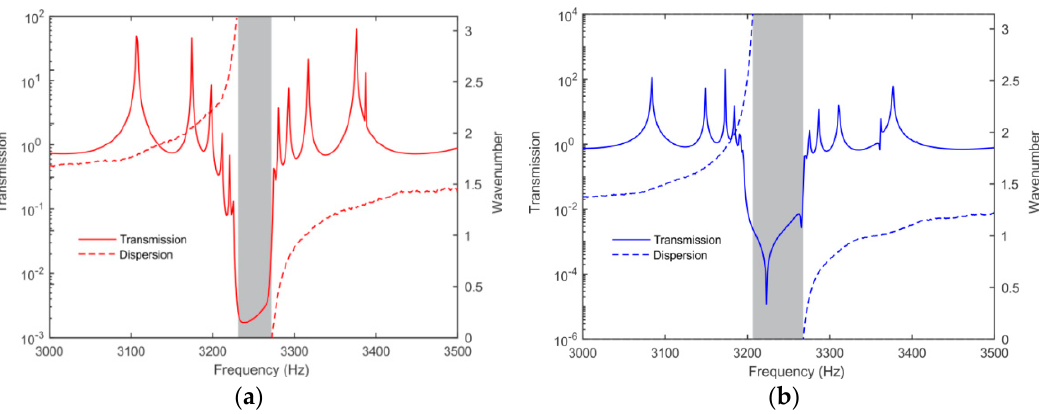
Figure 8. Frequency response and dispersion relation. ( a ) Conventional metamaterial beam; ( b ) Metamaterial beam with cavity.